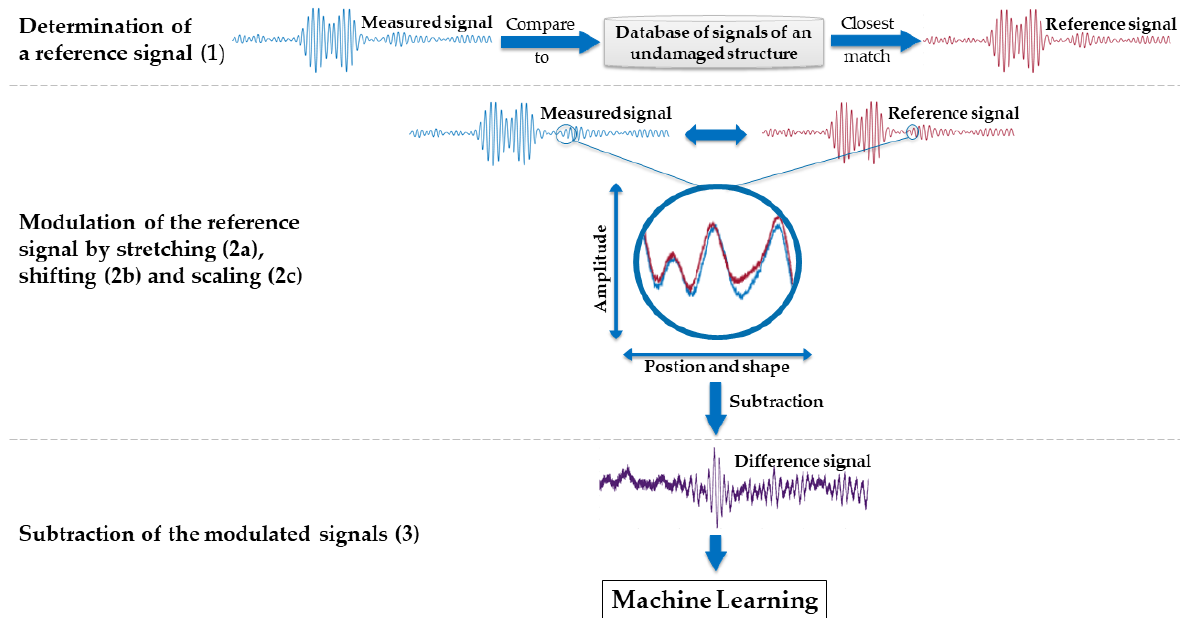
Figure 2. Pre-processing of the raw data to compensate for temperature-related effects by using optimal baseline selection (OBS) and baseline signal stretch (BSS).